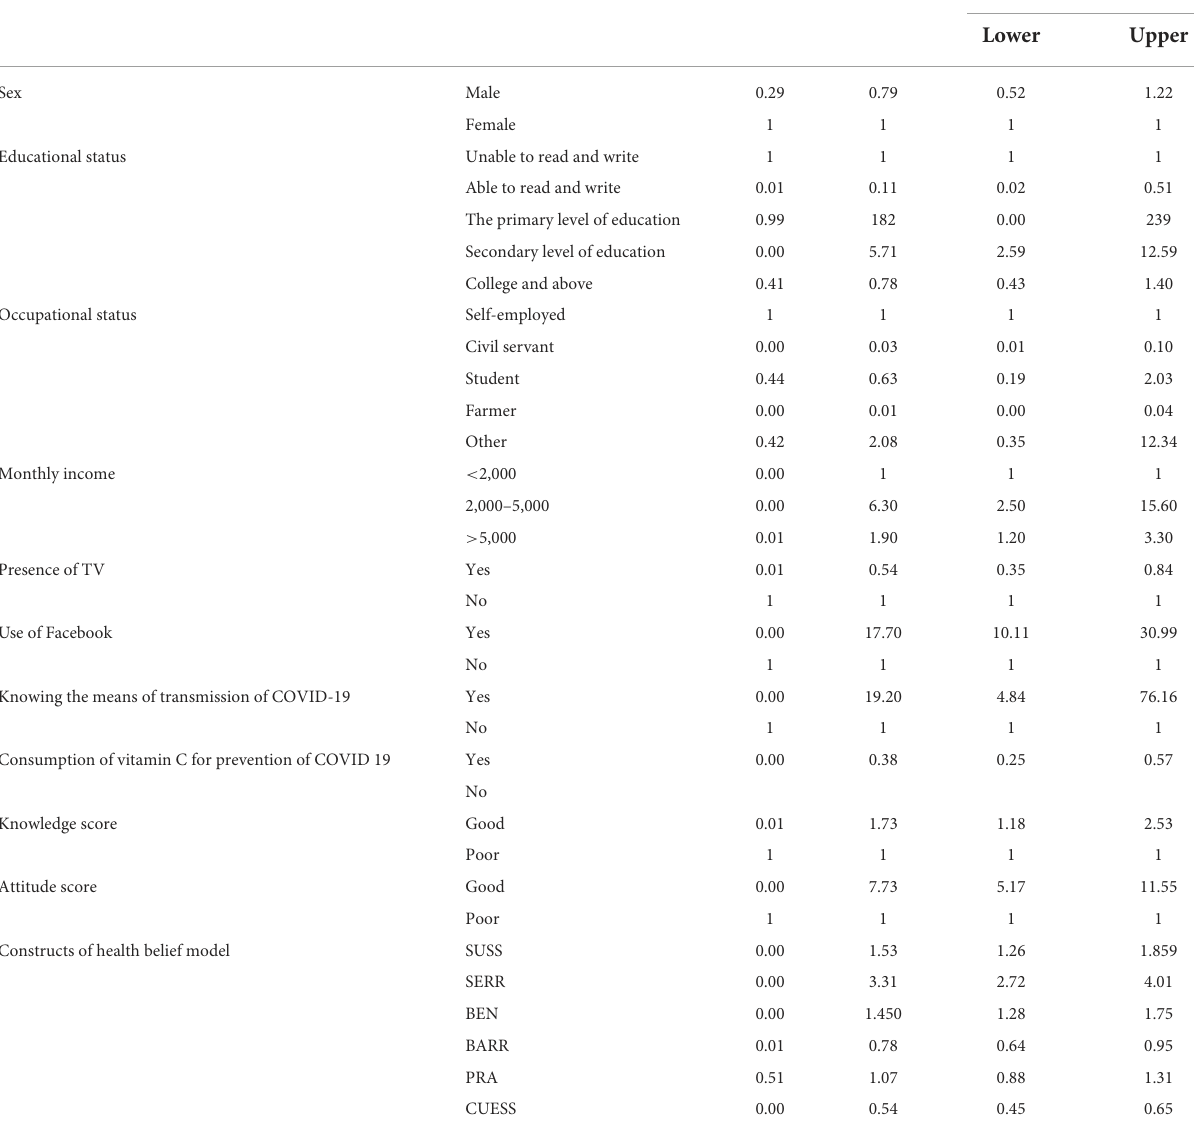
TABLE 5 Factors associated with the acceptability of COVID-19 vaccination.